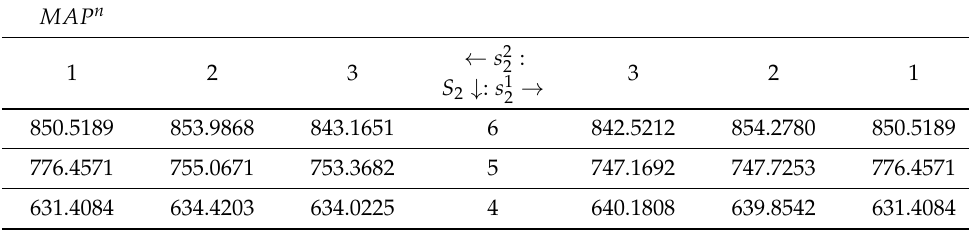
= 1) and ( s 2 , S 2 ) (fix s 2 2 2